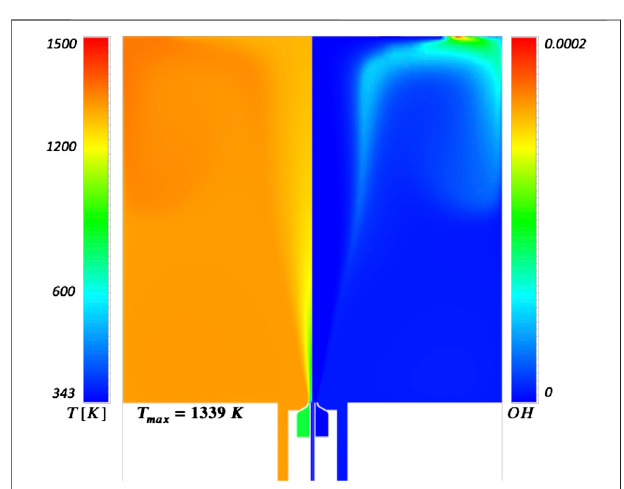
FIGURE 4 | Case 3 (5% H 2 ) temperature and OH